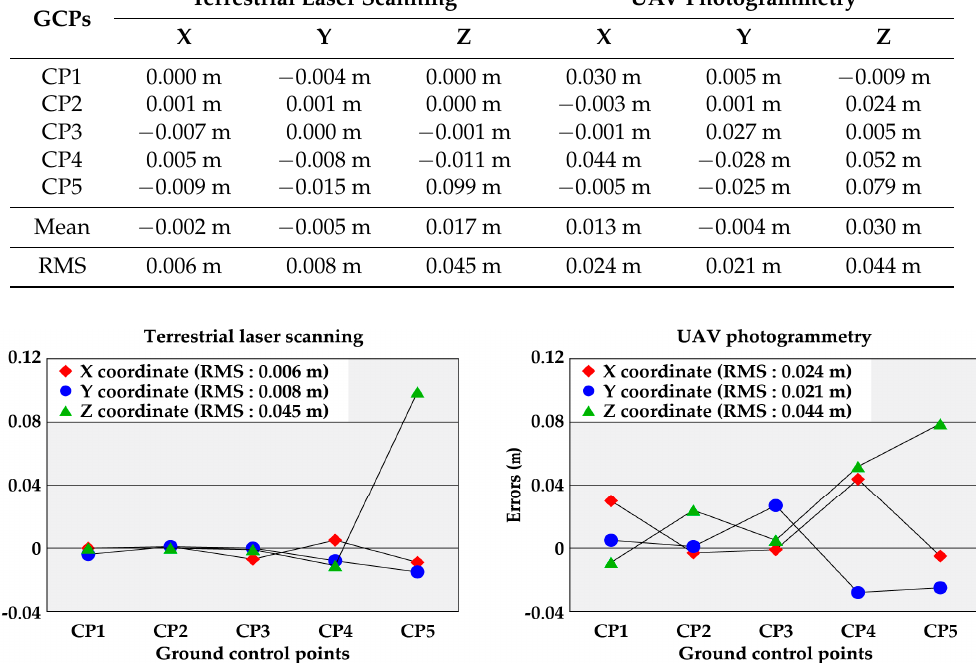
Figure 5. Graphs showing coordinate errors of the terrestrial laser scanning and UAV photogrammetry based on the five ground control points.